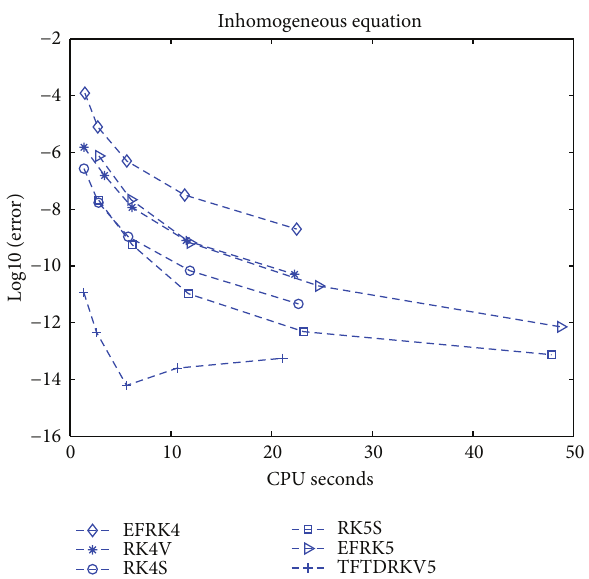
Figure 6: Efficiency curves for Problem 2.